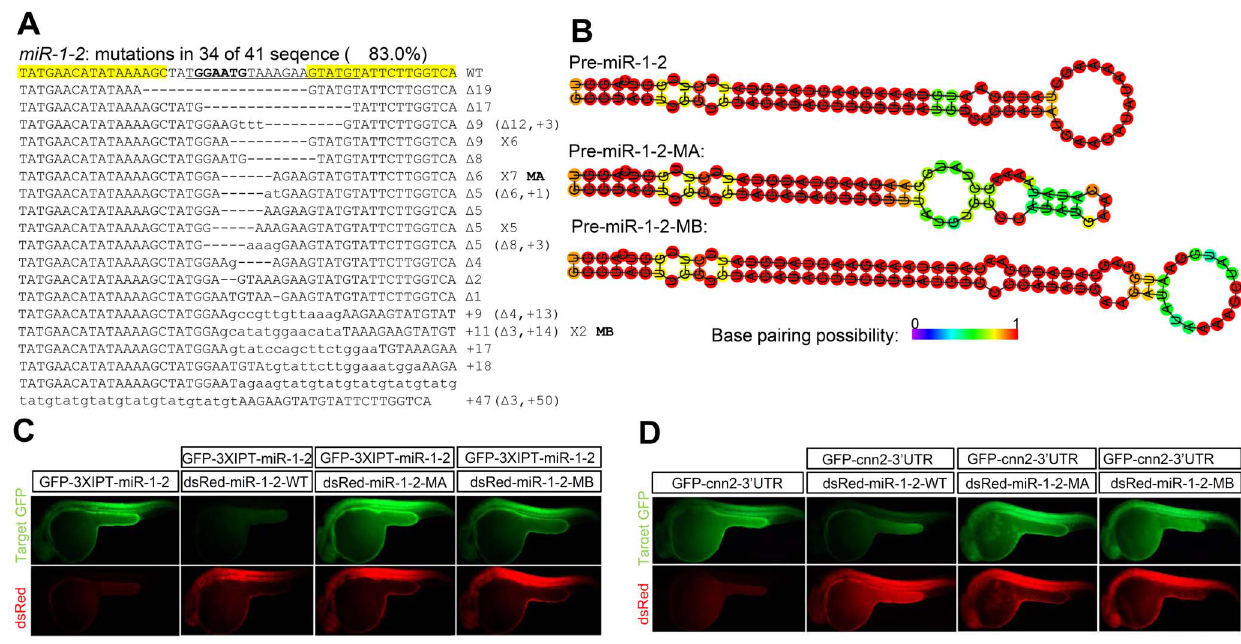
Figure 1. Targeted disruption of zebrafish miR-1-2 . ( A ) Frequency and spectrum of TALEN induced miR-1-2 mutations. The TALEN binding sites are shown in yellow background. DNA sequence encoding the mature miR-1-2 is underlined, with the seed sequence in bold. Deletions are indicated by dash lines and insertions are indicated by lowercase letters. The sizes of the insertions ( + ) or deletions ( D ) and the number of times each mutant allele appearing are shown on the right side of the mutant allele. ( B ) The hairpin structure of the wild-type pre-miR-1-2 and two pre-miR-1-2 mutants (MA and MB) in Panel A. ( C – D ) Functional suppression of target GFP expression by the wild-type or two mutated pre-miR-1-2. Messager RNA of GFP sensor (GFP-3XIPT-miR-1-2 or GFP- cnn2 -3 9 UTR) and RFP indicator expressing wild-type or mutant pre-miR-1-2 was co-injected into one-cell stage zebrafish embryos. Pictures were taken at 24 hours after injection. GFP-3XIPT-miR-1-2, GFP sensor containing three imperfect complementary sites to miR-1-2; GFP- cnn2 –3 9 UTR, GFP sensor containing the 3 9 UTR sequence of cnn2 (a miR-1-2 target gene); dsRed-miR-1-2, RFP indicator expressing mature miR-1-2. Fig. H and Table S3 in File S1). For both gene clusters, the fragment deletion frequency is lower than that of the indel mutations.